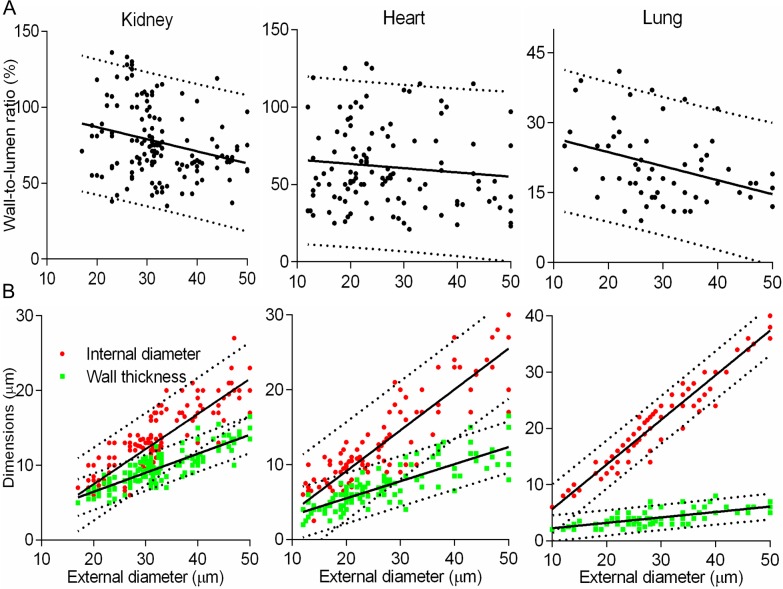
Detailed statistical analysis of primary data.(A) Wall-to-lumen ratio scatterplots were irregular with low r2 (solid lines), and wide 95% prediction bands (dashed lines). Corresponding statistics are shown in Table 1. (B) Scatterplots of primary data displayed certain incremental change in arterial dimensions. Coefficients r2 were moderate, and the pulmonary arteries had the best fitting value.